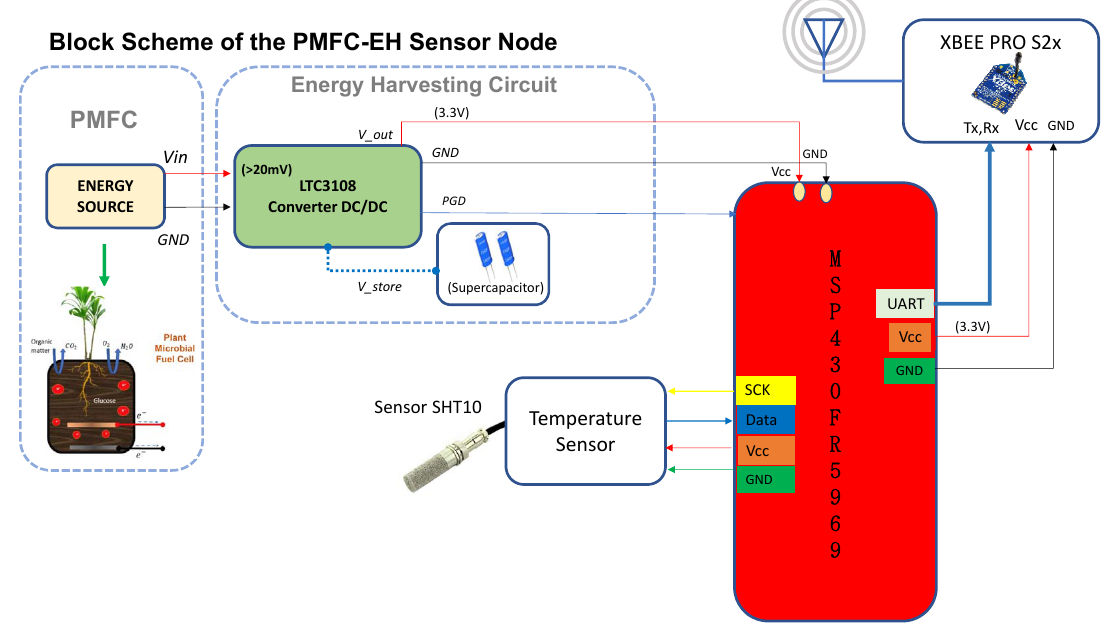
Figure 2. Conceptual PMFC-EH system for the IoT applications proposed in this paper.